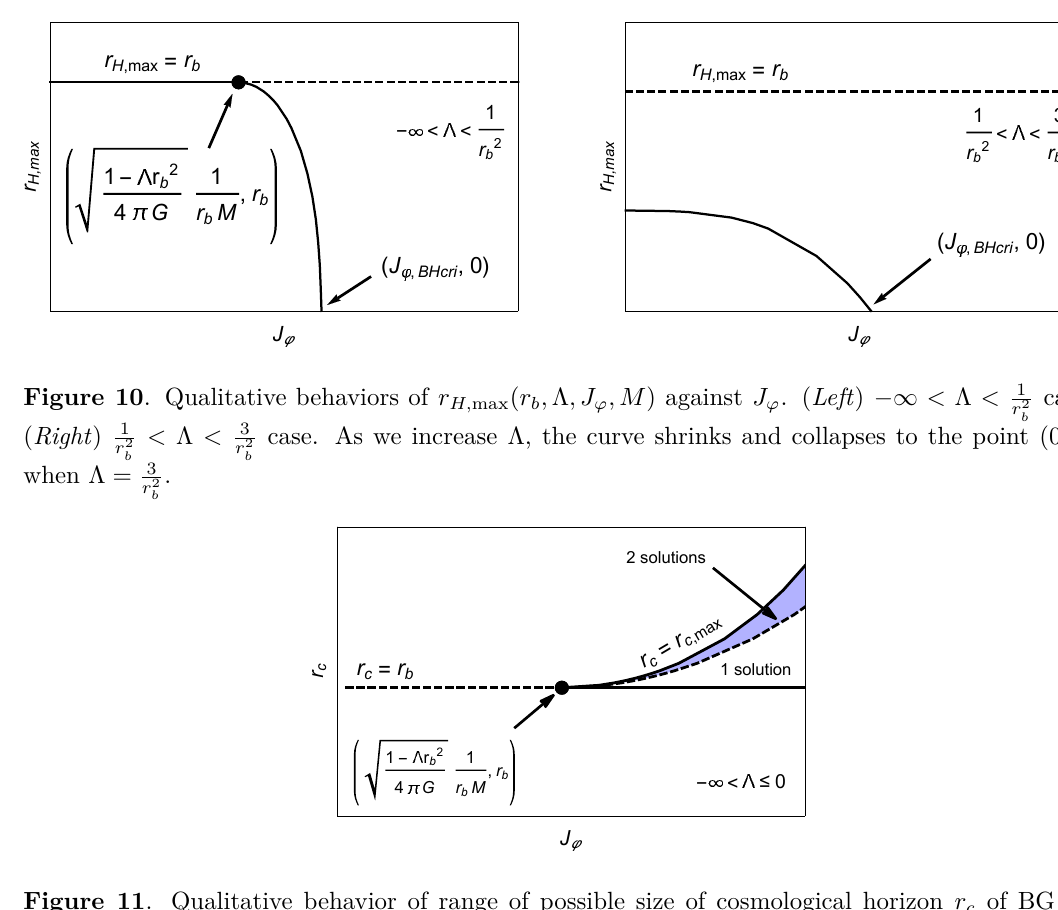
Figure 11 . Qualitative behavior of range of possible size of cosmological horizon r c of BG in- stanton against J when −∞ < Λ ≤ 0 . For 0 ≤ J ϕ q 1 − Λ r 2 Above , there exist BG instantons between r 1 b 4 πG r b M solutions with the same r in the shaded c